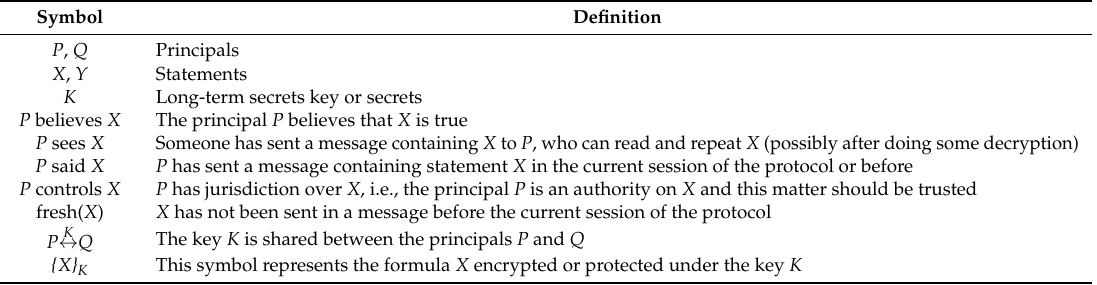
Table 2. Basic constructs utilized in the analysis of Claim